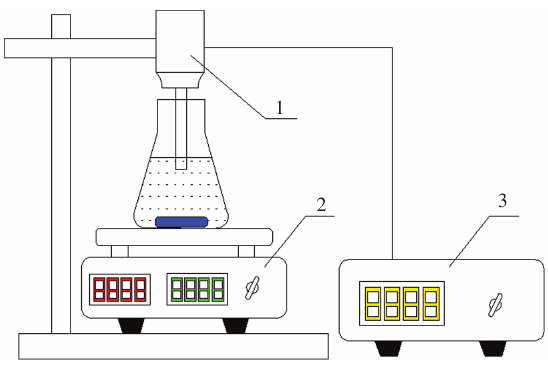
Figure 2: The ultrasonically assisted leaching